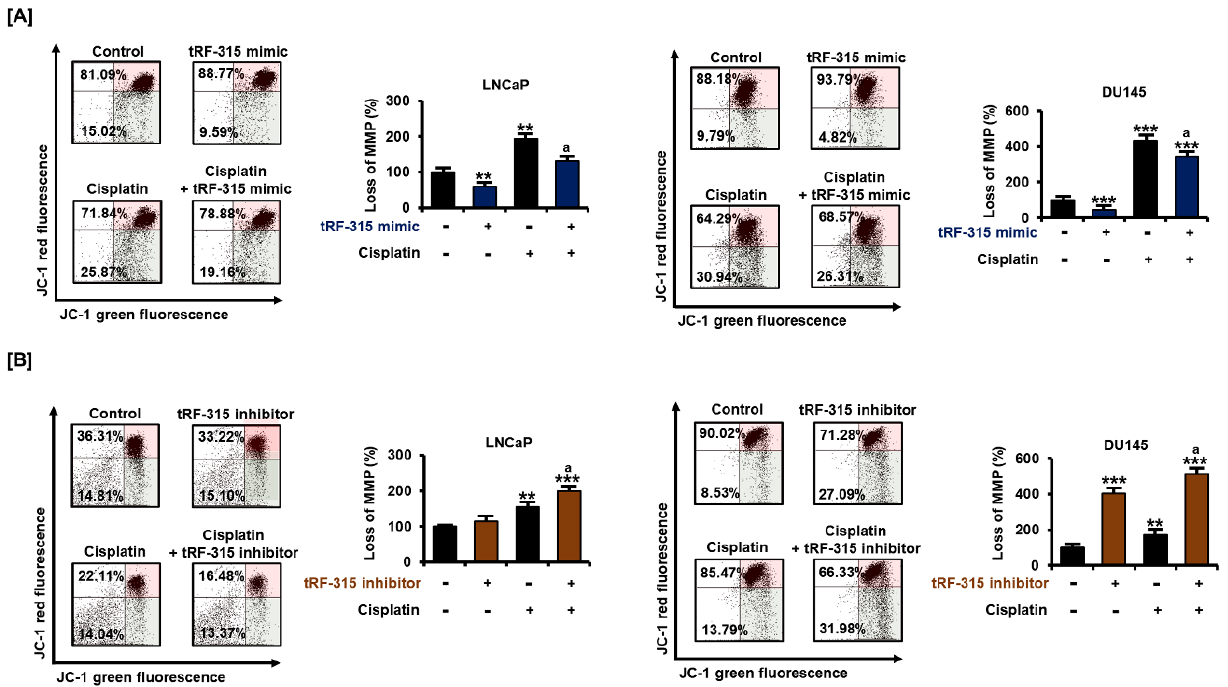
Figure 5. Effects of tRF-315 on mitochondrial membrane potential elevated upon cisplatin treatment in LNCaP and DU145 cells. ( A ) Change in mitochondrial membrane potential in response to transfection with tRF-315 mimic (20 nM) for 6 h and cisplatin (20 µ M) treatment for 48 h in LNCaP and DU145 cells was analyzed by JC-1 staining. ( B ) Change in mitochondrial membrane potential in response to transfection with the tRF-315 inhibitor (20 nM) for 6 h and cisplatin (20 µ M) treatment for 48 h in LNCaP and DU145 cells was analyzed by JC-1 staining. The lower right/upper right values were calculated for quantification. The value of the control group was expressed as 100%. The data represent three independent experiments. The asterisks indicate significant differences between the treated cells and control cells (*** p < 0.001 and ** p < 0.01). The symbol ‘a’ indicates a significant difference compared with cisplatin alone treatment group.